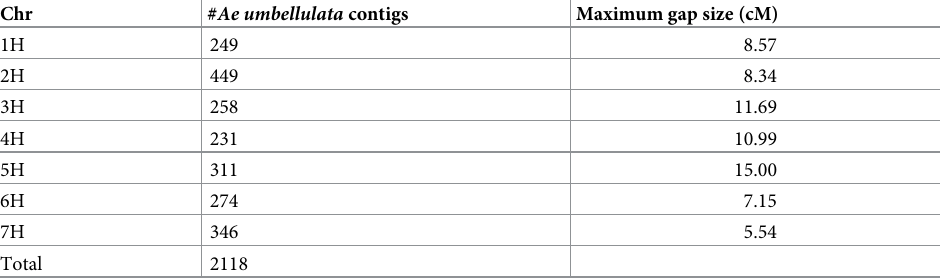
Table 3. Distribution of SNP-containing contigs from susceptible Ae . umbellulata accession PI 554395 assembly across barley